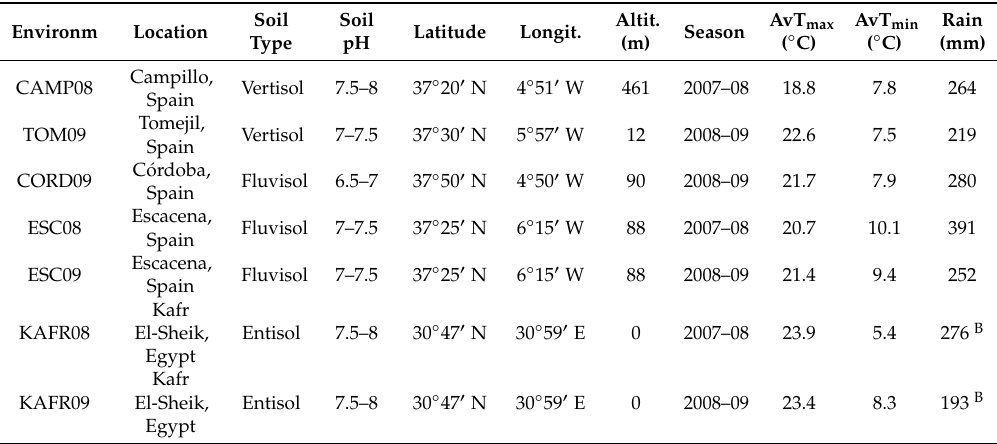
Table 1. Description of the environments (combination of location and season) of the trials of the multi-environment study. Summary climatic data corresponding to each growing season are provided (more detailed data used in Figures 3 and 4 are not listed